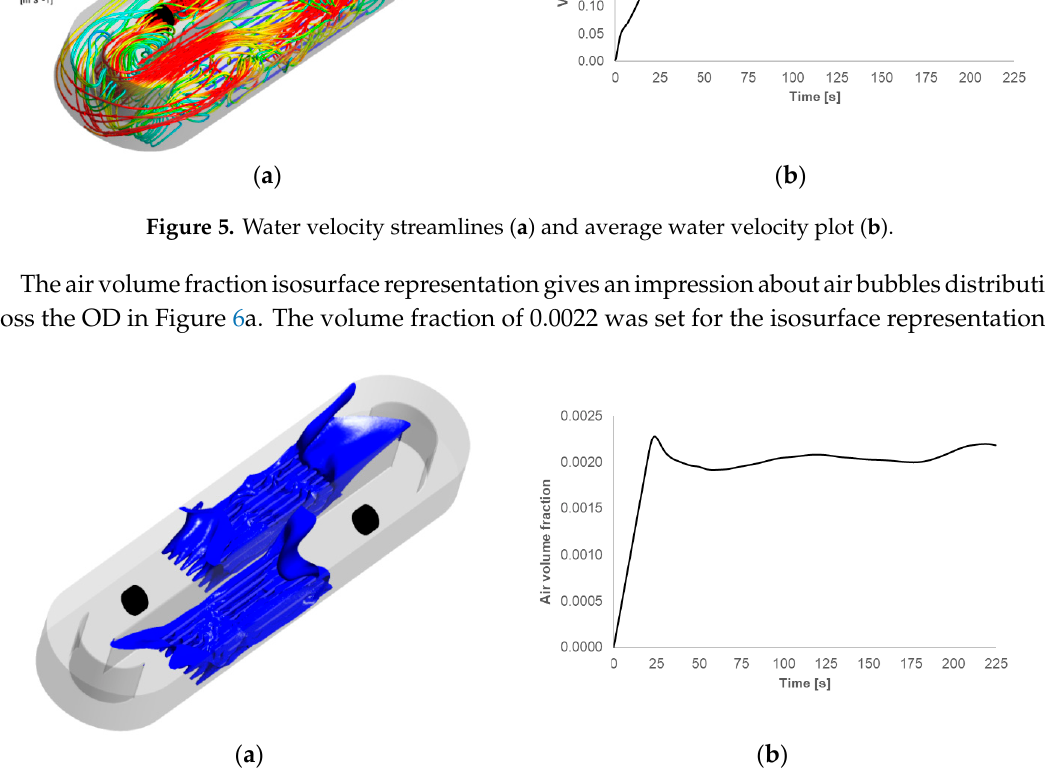
Figure 6. Air volume fraction isosurface ( a ) and air holdup plot ( b ).